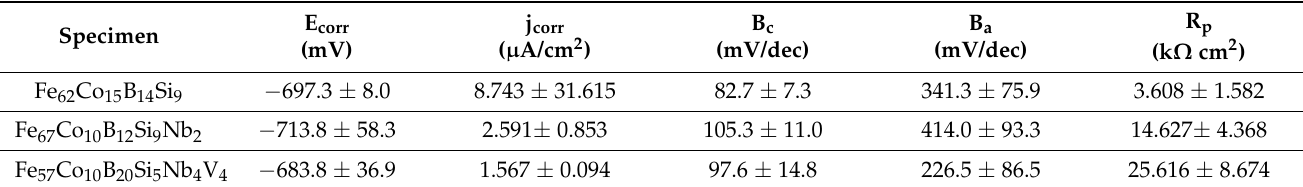
Table 1. Corrosion performance parameters obtained by potentiodynamic polarization.